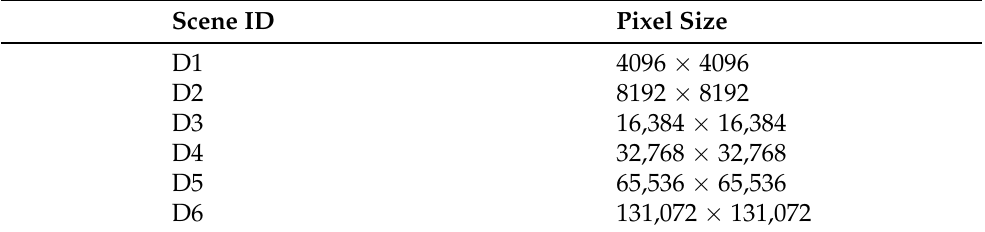
Table 2. The design of drawing